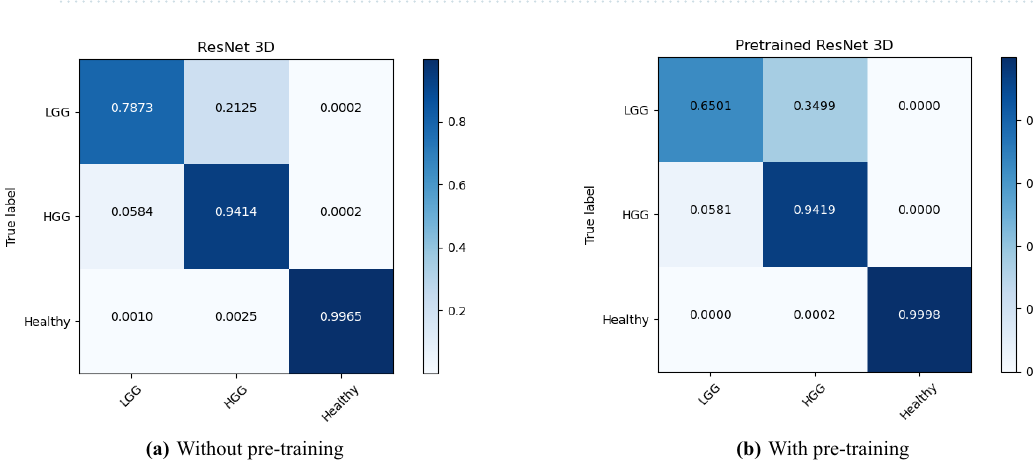
Figure 5. Confusion matrix for 3-fold cross-validation on ResNet mixed convolution.